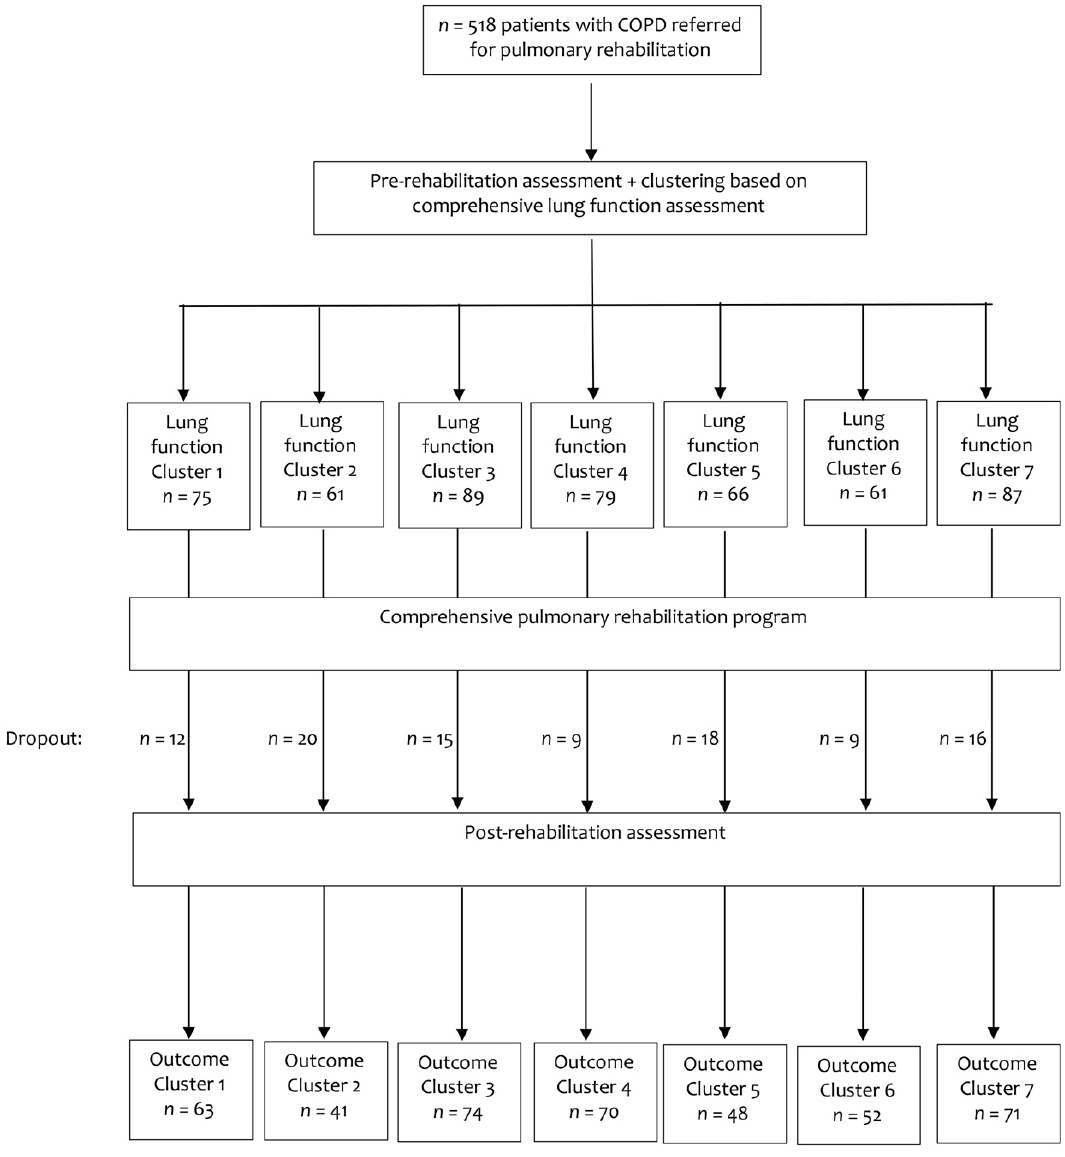
Figure 1. Patients before and after a 40-session comprehensive pulmonary rehabilitation program.